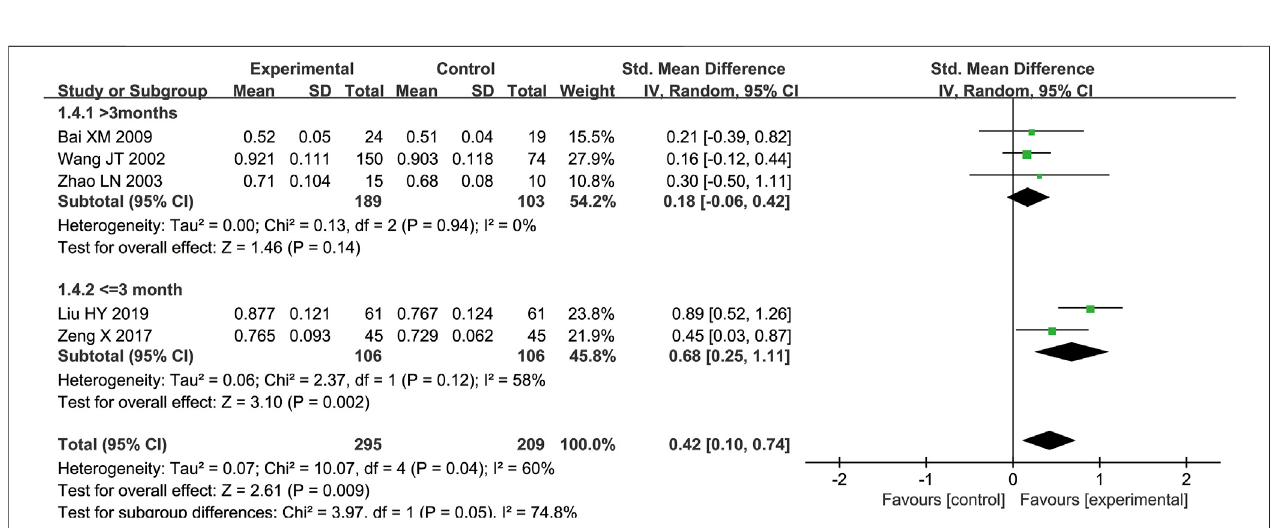
FIGURE 8 | Subgroup analyses for Epimedium as an alternative on the duration of the intervention.